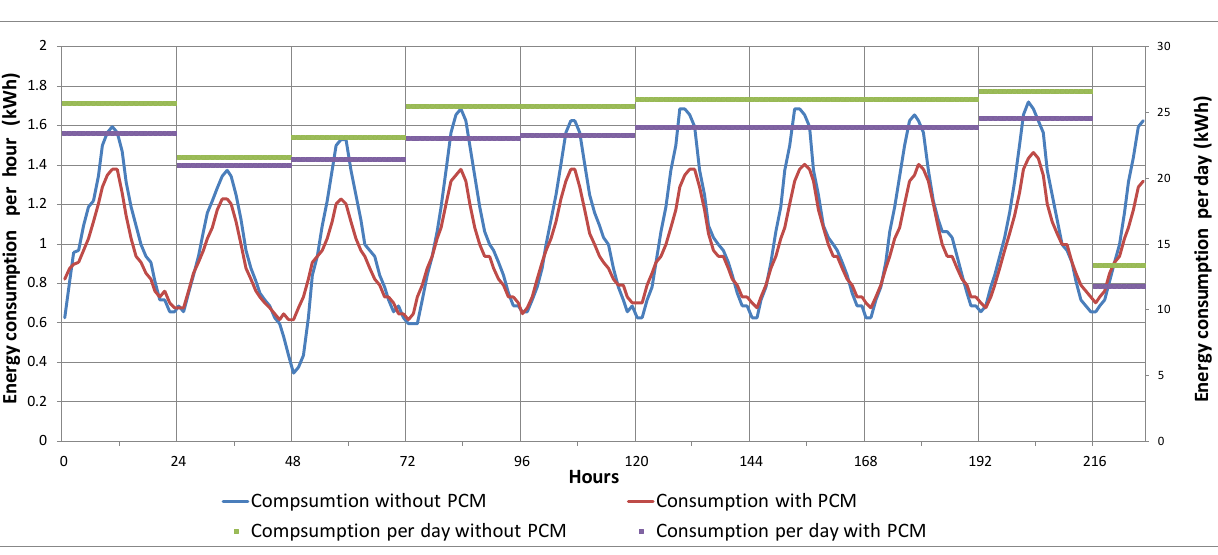
Figure 14. Predicted thermal consumption of the heat pump of the cubicle in the simulation with and without